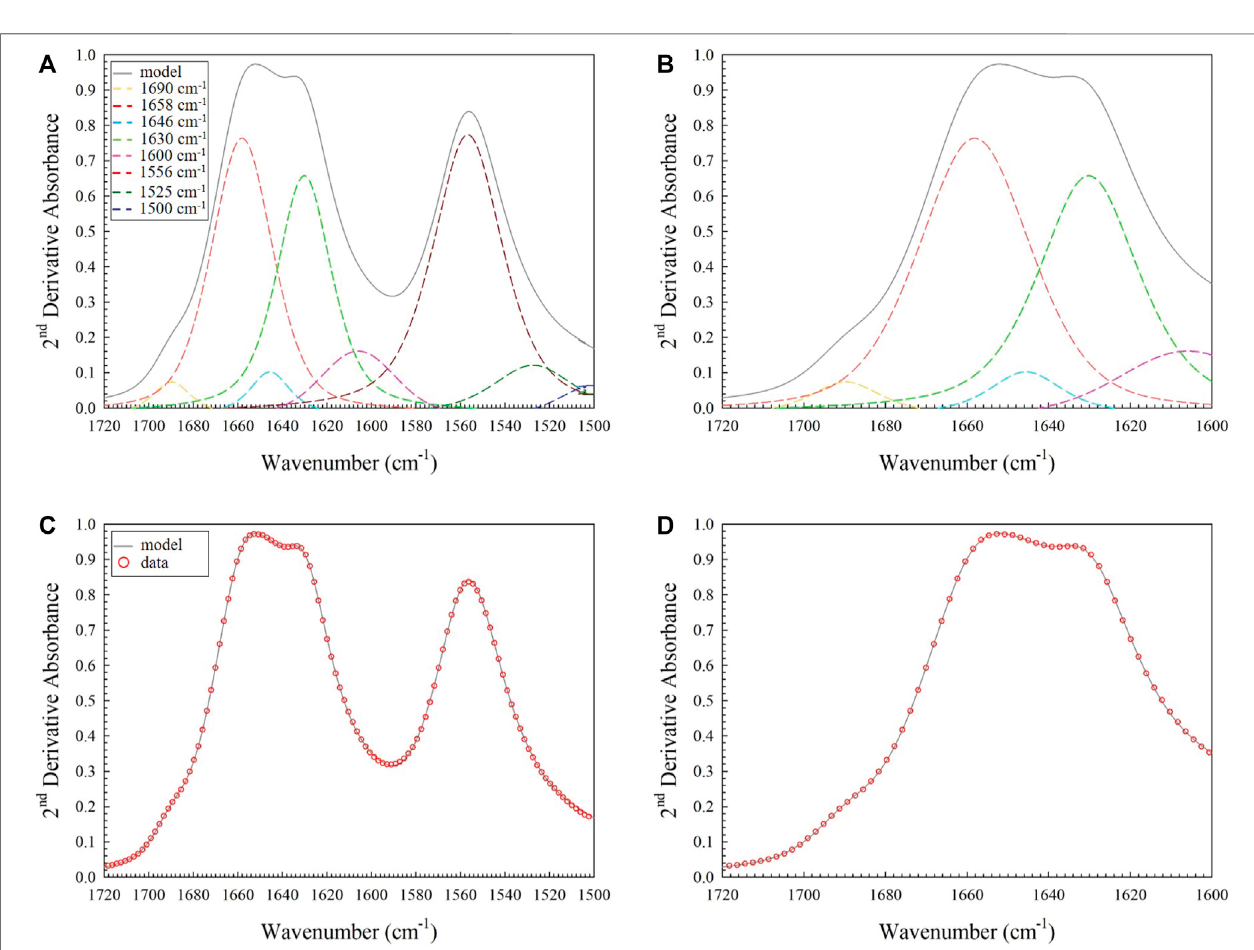
FIGURE 8 | (A) Example spectrum of the amide I and II bands found in untreated collagen gels. Three peaks were introduced to generally account for the amide II bandat~1556,~1525and~1500 cm − 1 withanotherpeakat~1600 cm − 1 inthetransitionregionbetweenamideIandamideIIbands; (B) Fitofthefourpeakswithnon- zero peak area identi fi ed in the amide I region only (1690, 1658, 1646 and 1630 cm − 1 – the peak due to protein secondary structure termed “ turns ” did not produce a non-zero area in fi tting); (C) Fit of the model (grey line) to the data (red open circles) for the amide I and II band region; (D) Fit of the model (grey line) to the data (red open circles) for the amide I